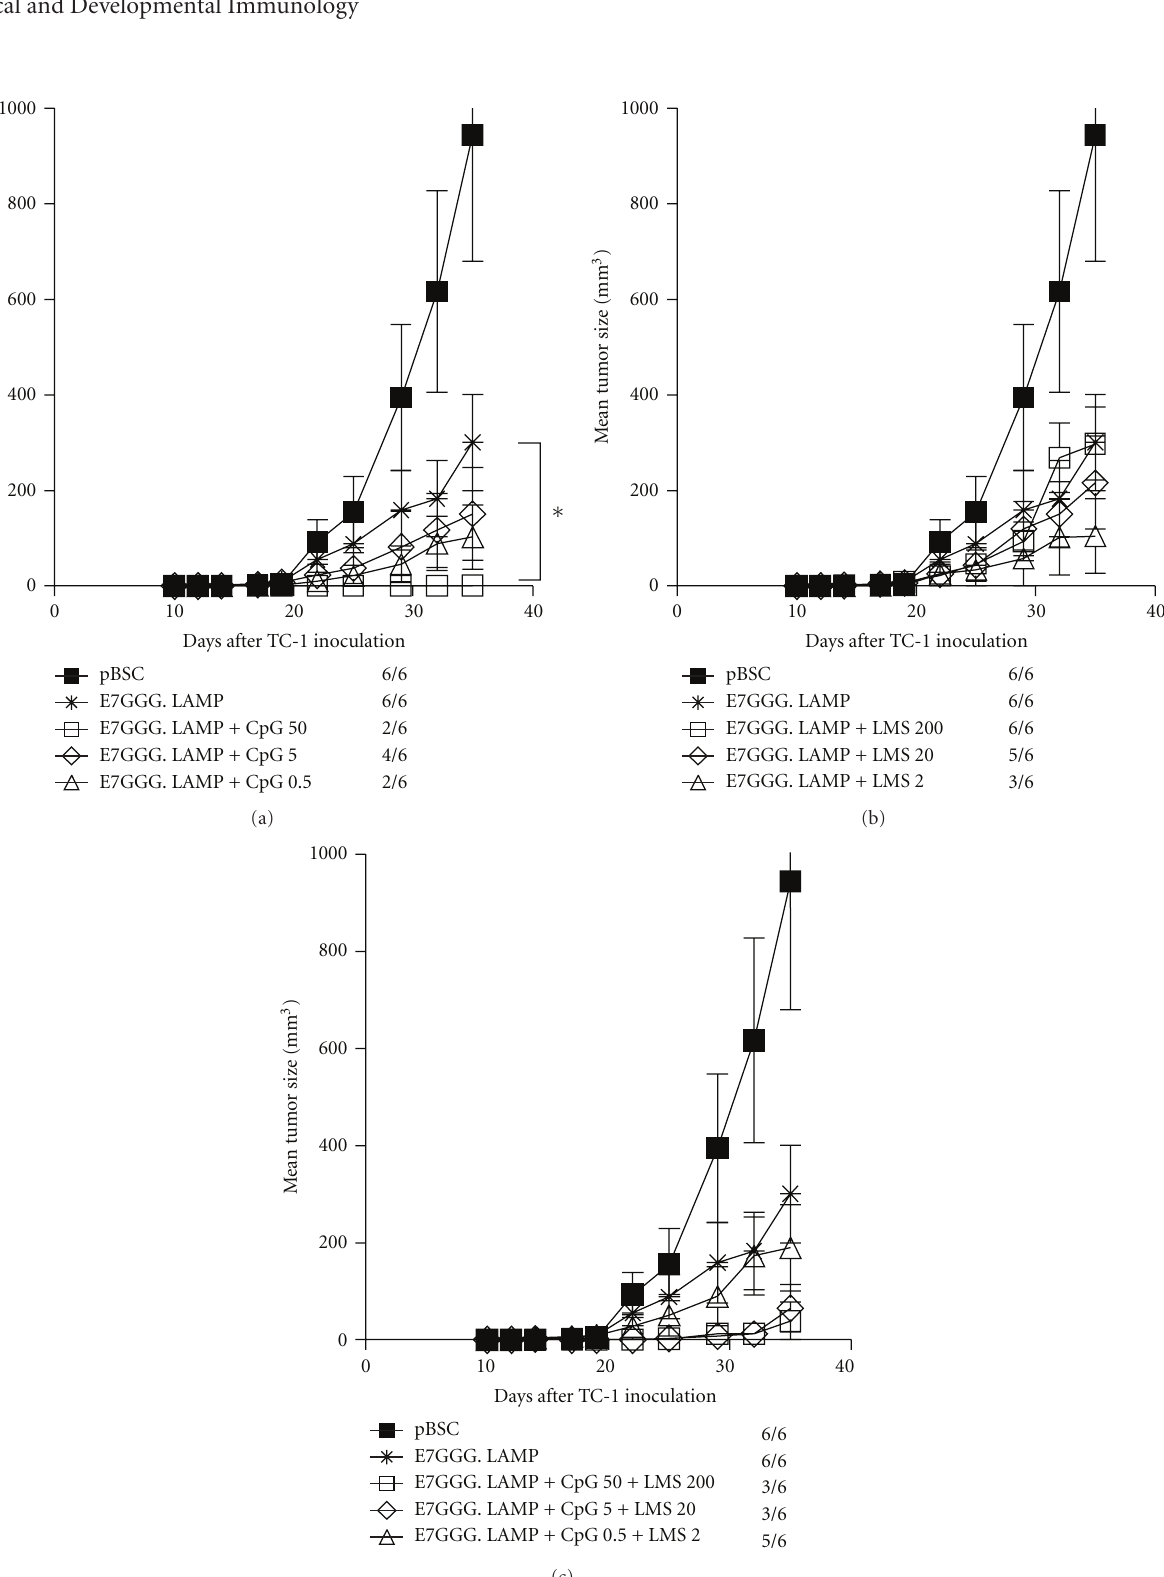
Figure 3: Antitumor e ff ect of systemic administration of single adjuvants or their combinations. C57BL/6 mice ( n = 6) were s.c. inoculated with 3 × 10 4 TC-1 cells and immunized by a gene gun with 1 μ g of pBSC/E7GGG.LAMP three and ten days later. The pBSC plasmid was used as a negative control. CpG-ODN (a), LMS (b), or their combinations (c) were i.p. injected at indicated doses on the days of DNA vaccination. The graphs (a), (b), and (c) were constructed from the results of the same experiment. No. of mice with a tumor/no. of mice in the group is indicated. Bars: ± SD; ∗ P < 0 .